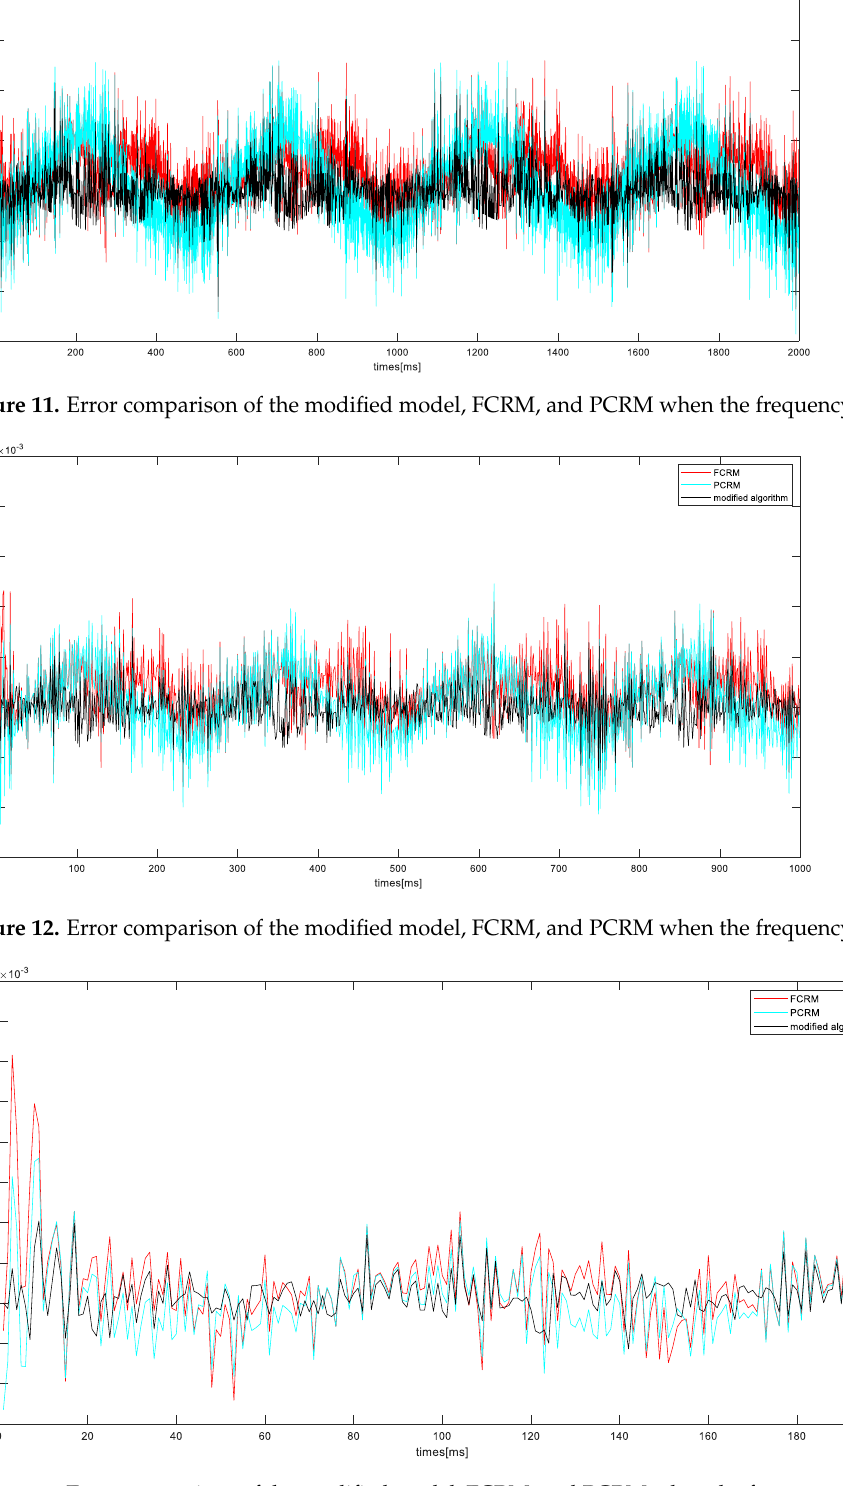
Figure 13. Error comparison of the modified model, FCRM, and PCRM when the frequency is 100 Hz.